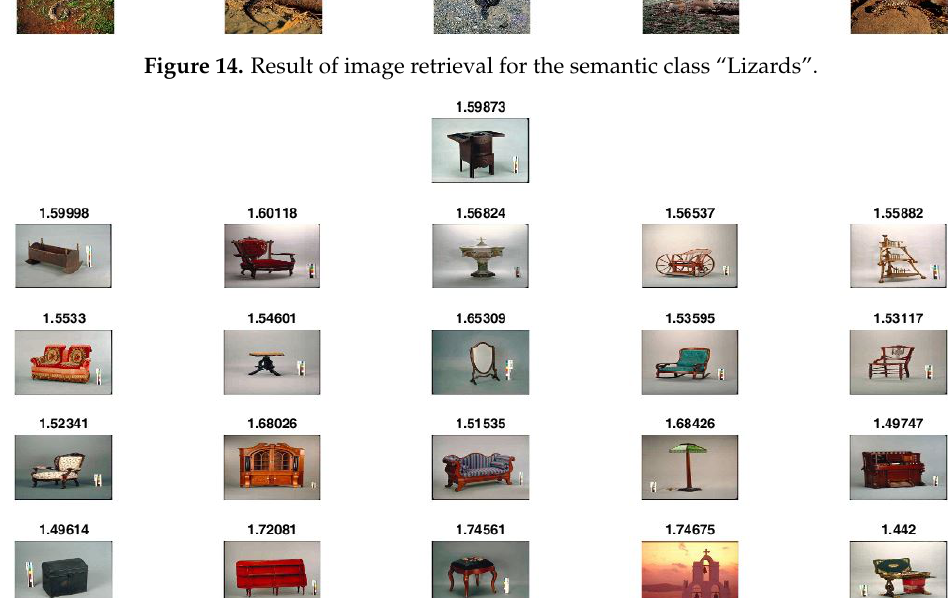
Figure 15. Result of image retrieval for the semantic class “Antique